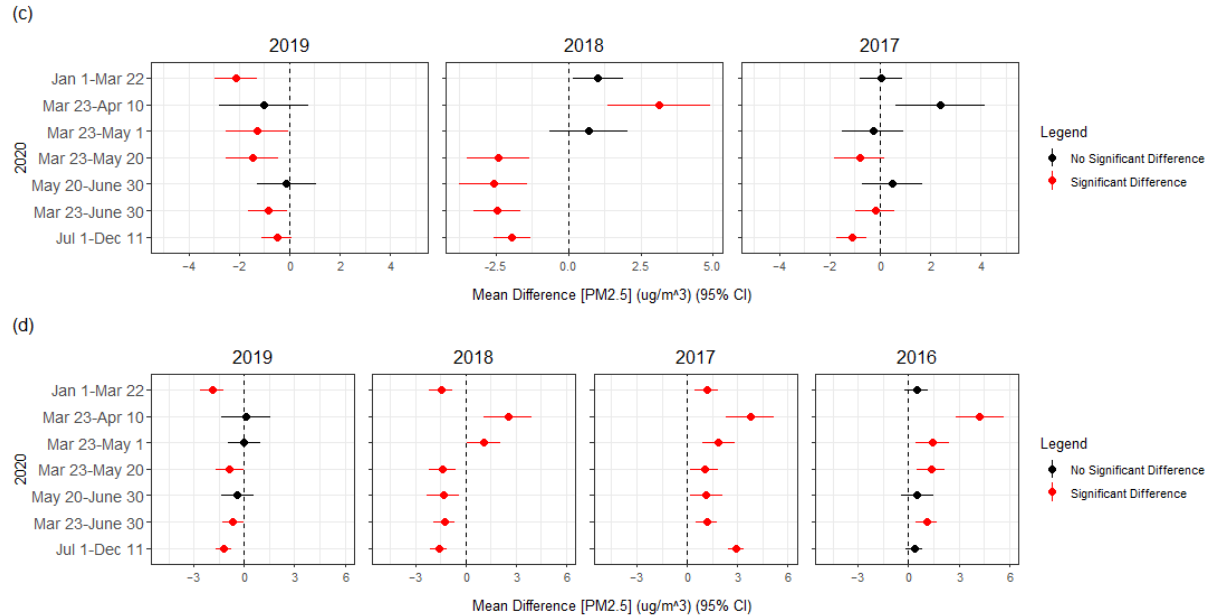
Figure 14. Post hoc test results for intra-annual and interannual PM 2.5 comparisons at the Near Road and Taft sites: ( a ) intra-annual at Near Road; ( b ) intra-annual at Taft; ( c ) interannual at Near Road; ( d ) interannual at Taft. The circles represent the difference in mean hourly PM 2.5 concentrations between the two time periods on each axis along with the 95% confidence interval (e.g., top left of top figure: (mean PM 2.5 23 March–10 April) − (mean PM 2.5 1 January–22 March) = 1.512 ug/m 3 ).